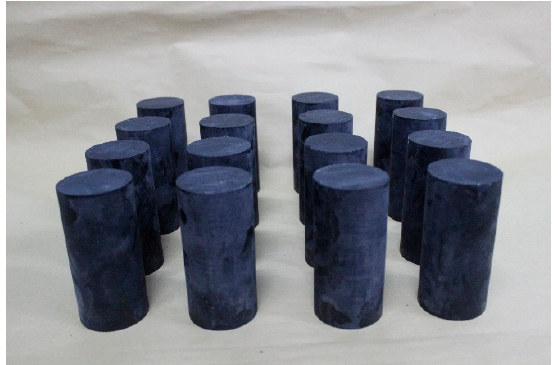
Figure 1. Part of the samples.